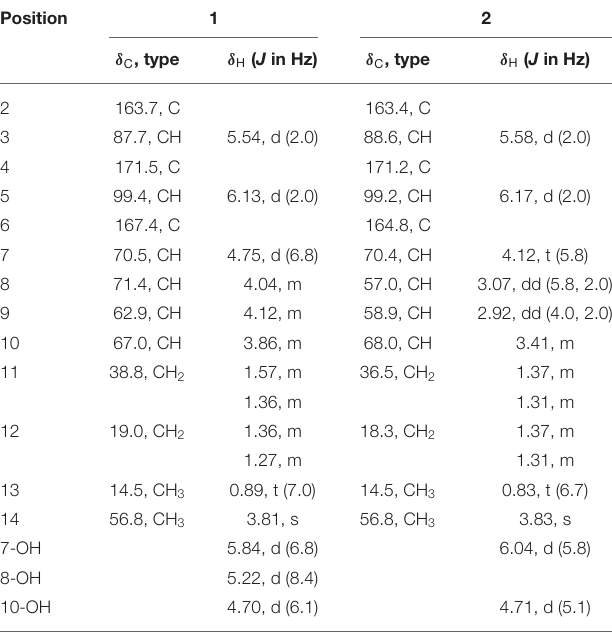
TABLE 1 | 1 H NMR and 13 C NMR Data for 1 and 2 a